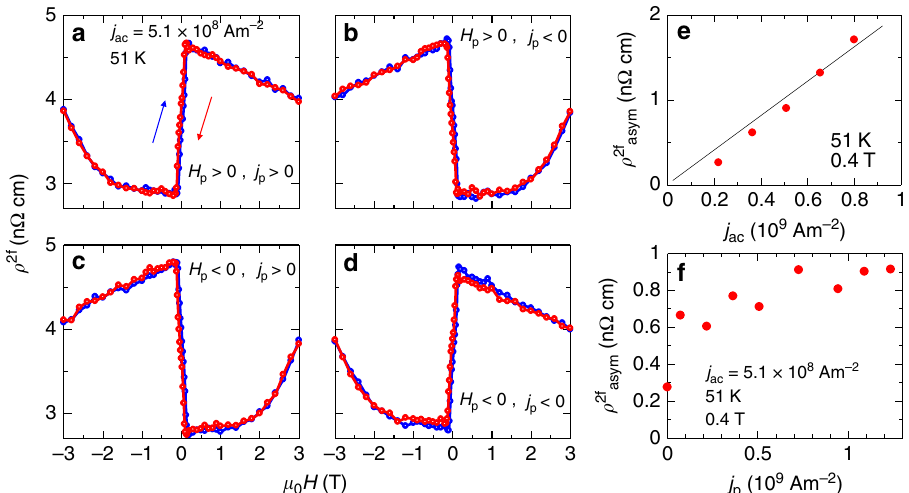
Fig. 3 Electric current control of helicity. a – d Magnetic fi eld dependence of the 2nd harmonic contribution of electrical resistivity ρ 2f after the poling procedure with the positive and negative magnetic fi elds H p and dc electric currents j p . The magnitudes of j p and ac electric current for the measurement j ac are 1.1 × 10 9 Am − 2 and 5.1 × 10 8 Am − 2 , respectively. e ρ 2 f at 51 K and 0.4 T as a function of j ac measured after poling with j p = 1.1 × 10 9 Am − 2 . f ρ 2 f asym 51 K and 0.4 T as a function of j p